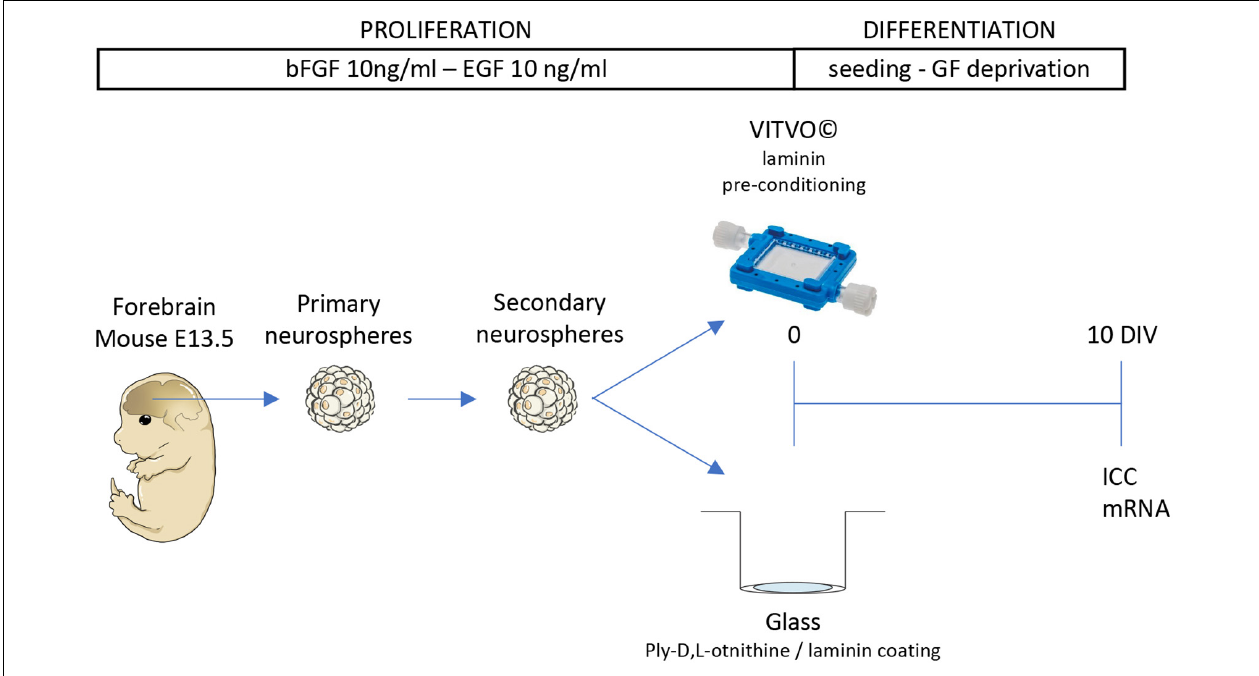
FIGURE 1 | Cell culture procedure. Schematic representation of the experimental protocol. Cells were isolated from the forebrain of the fetal mouse (E13.5) and maintained as 3D suspension cultures (neurospheres). After the formation of the secondary neurospheres, cells were seeded in VITVO pre-conditioned with laminin or glass coated with poly-L-ornithine and laminin. After 10 days in culture (DIV), cells were stained for immunocytochemistry (ICC) or gene expression analysis.